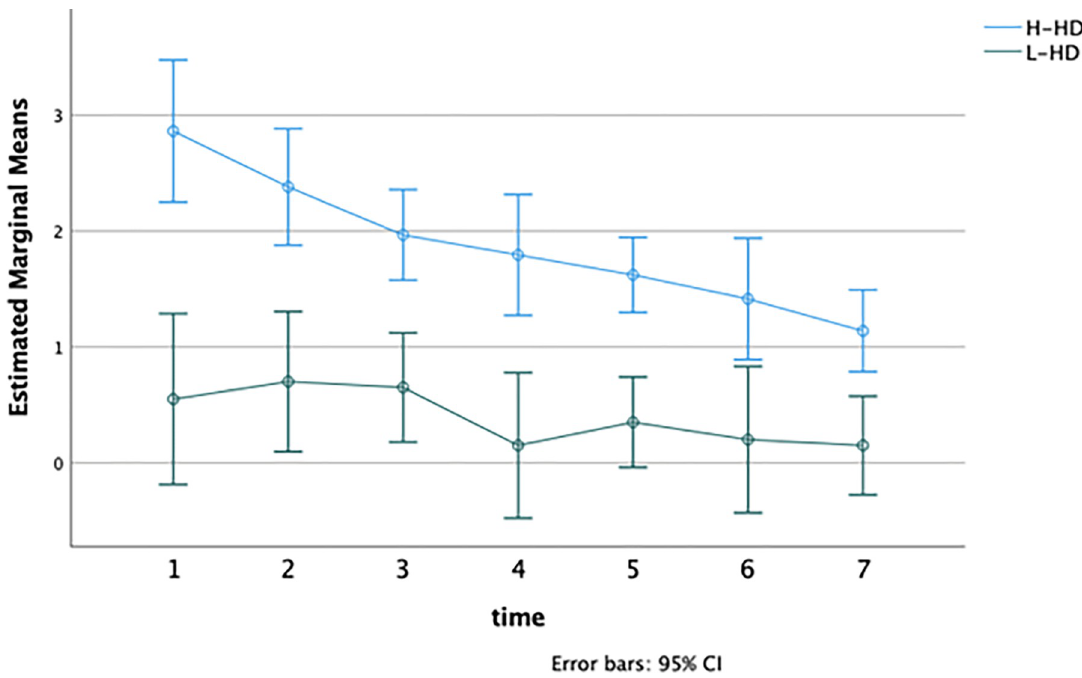
Fig 3. Difference in the frequency of negative emotions object-related referred each day. Notes : H-HD: group of individuals with higher hoarding features; L-HD: group of individuals without hoarding features; Time 1–7: number of the day.